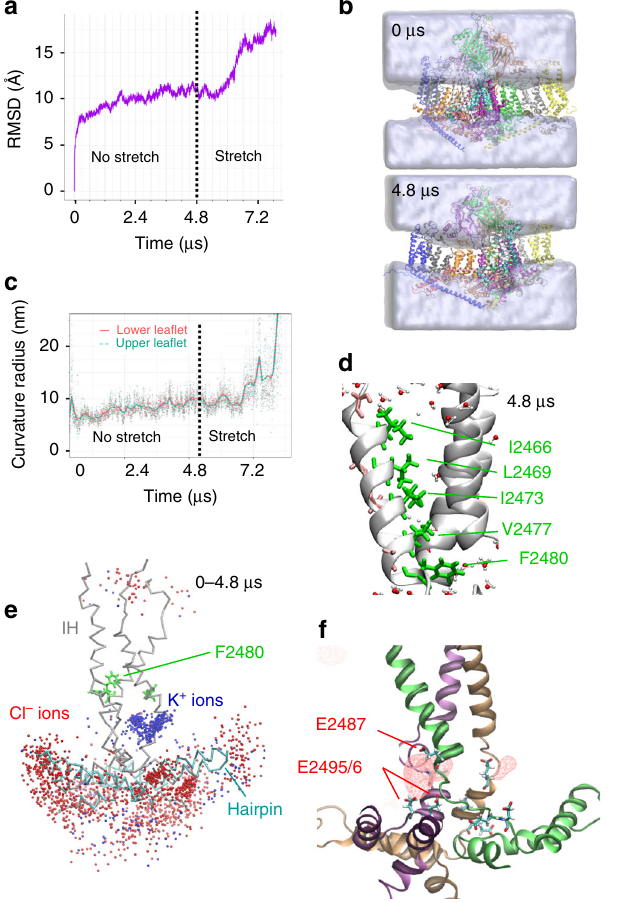
Fig. 2 Identi fi cation of a putative Yoda1 binding site and binding pathway. a Accumulated positions of all simulated ligands (every 24 ns) along 4.8 µ s trajectory. The backbone is represented at t = 4.8 µ s. b RMSF time course for each simulated ligand (L1 – L20) colored as indicated from the scale from lower (blue) to higher (red) values. c Accumulated L13 positions sampled every 24 ns from 0 (red) to 4.8 µ s (blue) onto the backbone shown at 4.8 µ s. Orange backbone corresponds to the 1961 – 2063 region. d Positions of L13 (licorice) sampled at the indicated time against the protein backbone (cyan: Piezo repeat B, magenta: Piezo repeat A, brown spheres: phosphate groups). e Positions of A1718, A2091 and A2094 and L13 inside the binding pocket sandwiched between Piezo repeats A (magenta) and B (cyan). f Dotted plot showing Yoda1-induced calcium signals in Δ PZ1 cells co-transfected with GC6 and the indicated constructs or transfected with GC6 only (control). g Position of L20 relative to surrounding small residues at 4.8 µ s. h Dotted plot showing Yoda1-induced calcium signals in Δ PZ1 cells co-transfected with the indicated constructs and GC6 or transfected with GC6 only (control). In f , h the numbers indicate the number of independent experiments n and each data point represents an average of at least 10 individual cells. Source data are provided as a Source Data fi le. Error bars = standard errors of mean values. Two-tails Mann – Whitney U -tests were performed to compare data distribution between WT and mutants/control for 100 µ M Yoda1. Asterisks indicate standard p -value range: *, 0.01 < p < 0.05; **, 0.001 < p < 0.01; ***, 0.001 < p < 0.01 and n.s. (non-signi fi cant): p > 0.05